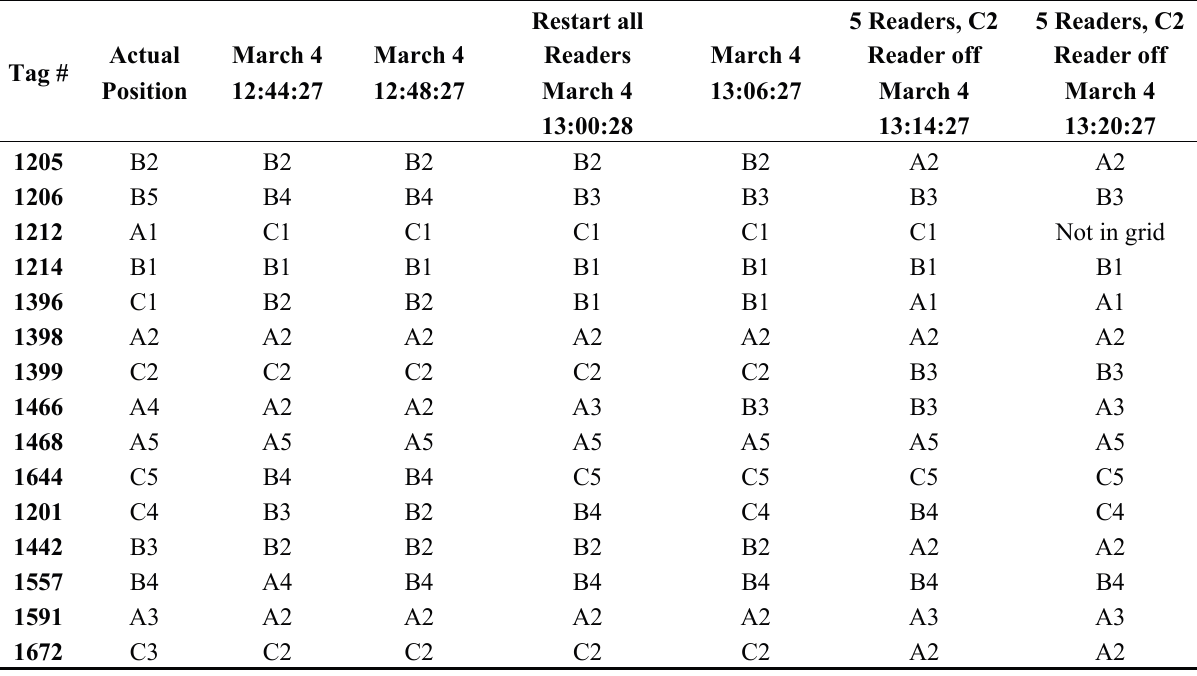
Table 3. Comparisons of the tags’ actual position and location by RFID using six and five readers at different